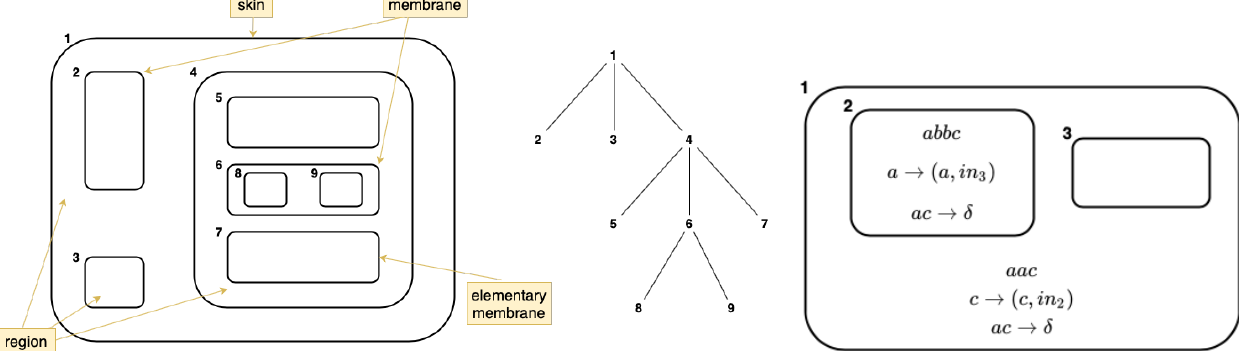
Figure 2. Representation of basic components in a membrane system that could be transformed into a tree shape using is-compound-of relationships, and an example with object multisets and evolution rules (from left to